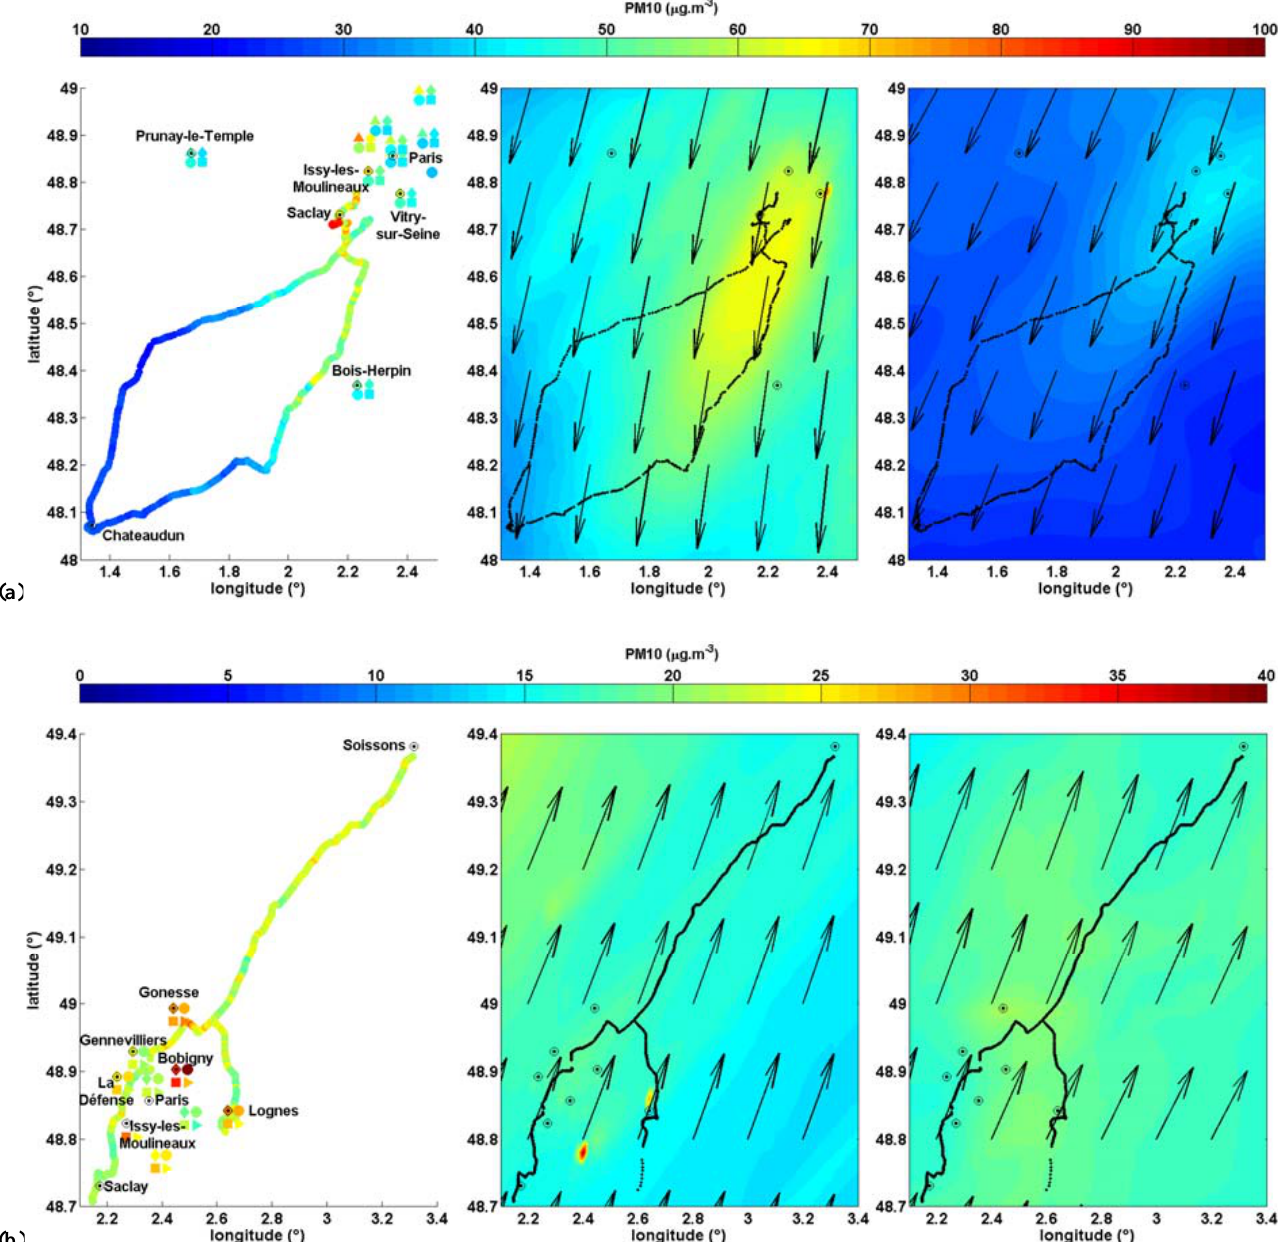
Fig. 3. Spatial distributions of wet PM 10 at 12:00 (UT) on 1 (a) and 15 (b) July derived from lidar measurements with the peri-urban relationship at 210m height (left column) and simulated at 12:00 (UT) with the POLYPHEMUS model at 210m height (central column) and the CHIMERE model at 250m height (right column). Black arrows representing the wind at ∼ 250m height used in POLYPHEMUS and CHIMERE simulations are shown on the central and right panels. Dry PM 10 from AIRPARIF ground-based network are indicated by filled symbols at 13:00 (up triangles), 14:00 (diamonds), 15:00 (rounds), 16:00 (squares), 17:00 (right triangles), 18:00LT (pentagrams) in the left column. Note that for 15 July a mixing of dust and peri-urban relationships has been used in lidar